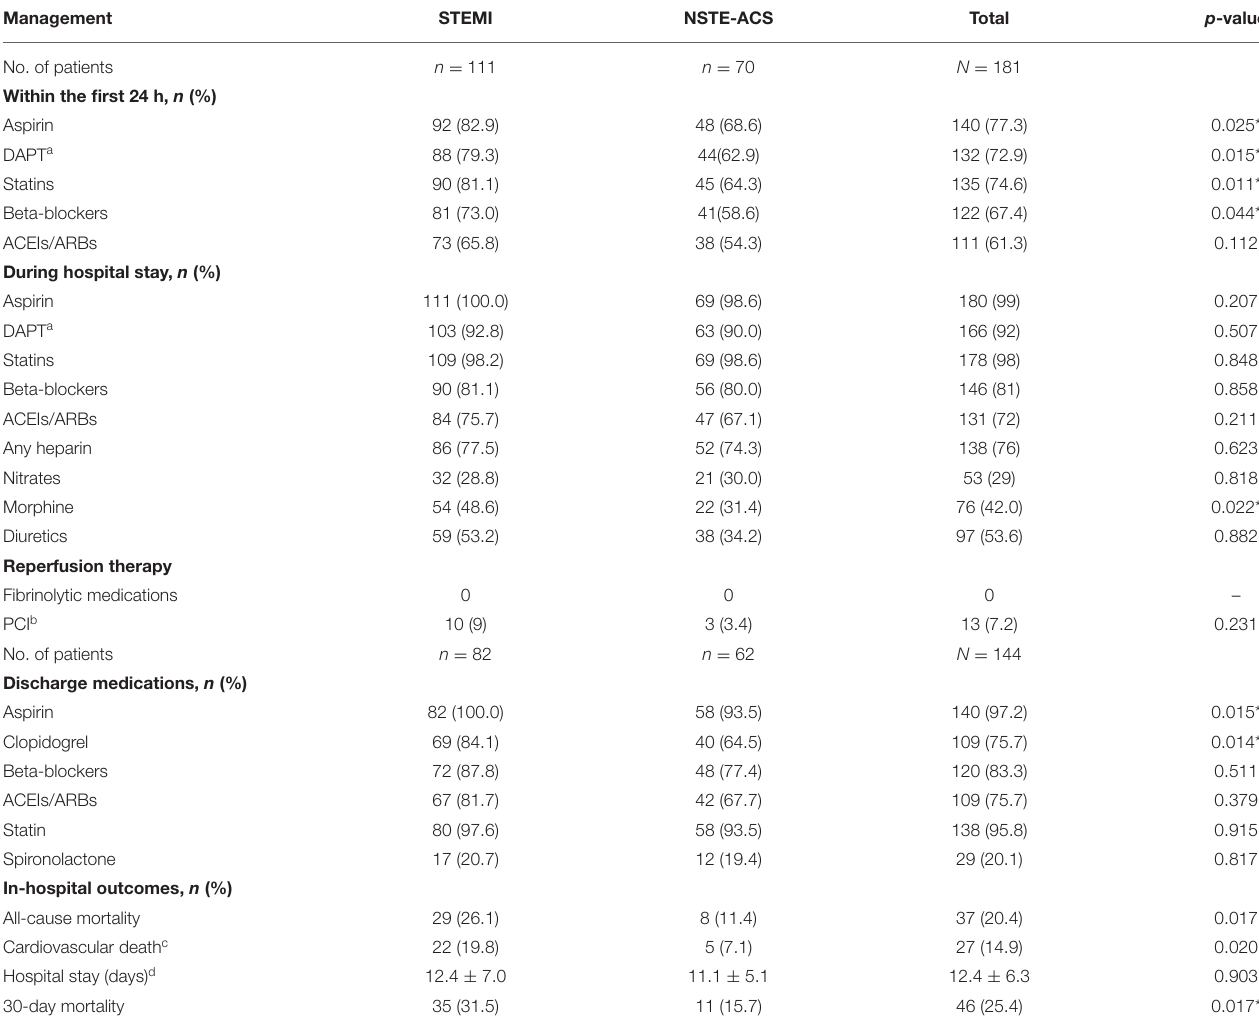
TABLE 3 | In-hospital management and outcomes among patients admitted with ACS.